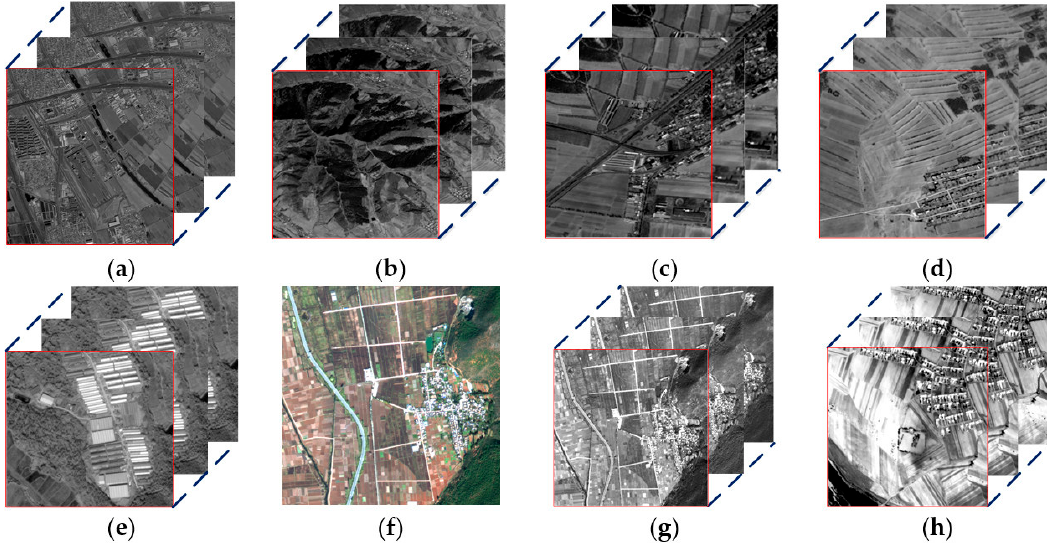
Figure 7. Experimental images. ( a ) city building area; ( b ) mountain area; ( c ) road area; ( d ) plain area; ( e ) plant area; ( f ) farmland area; ( g ) different band of ( f ); ( h ) village area.